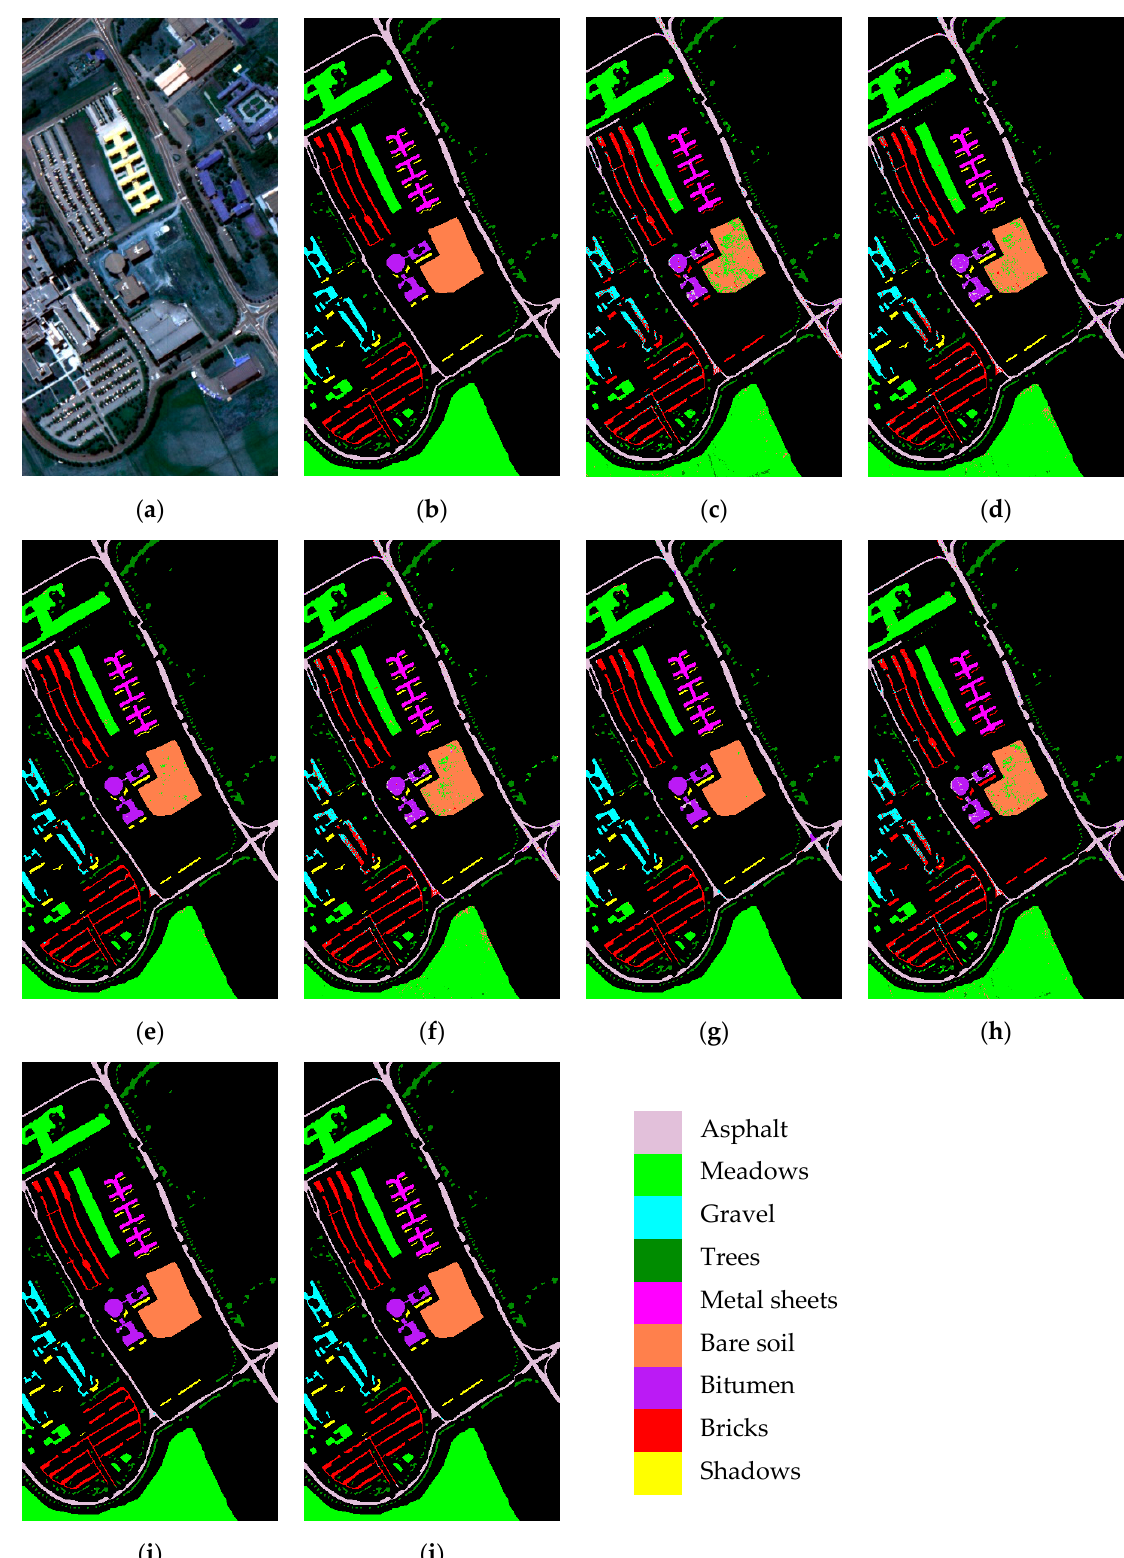
Figure 5. Hyperspectral image classification results of the Pavia University Dataset. ( a ) False-color image. ( b ) Ground truth. ( c ) RF. ( d ) SVM HSI . ( e ) SVM HSI&GLCM . ( f ) NN. ( g ) LetNet-5. ( h ) SPE-CNN. ( i ) SPA-CNN. ( j ) SSFIN.